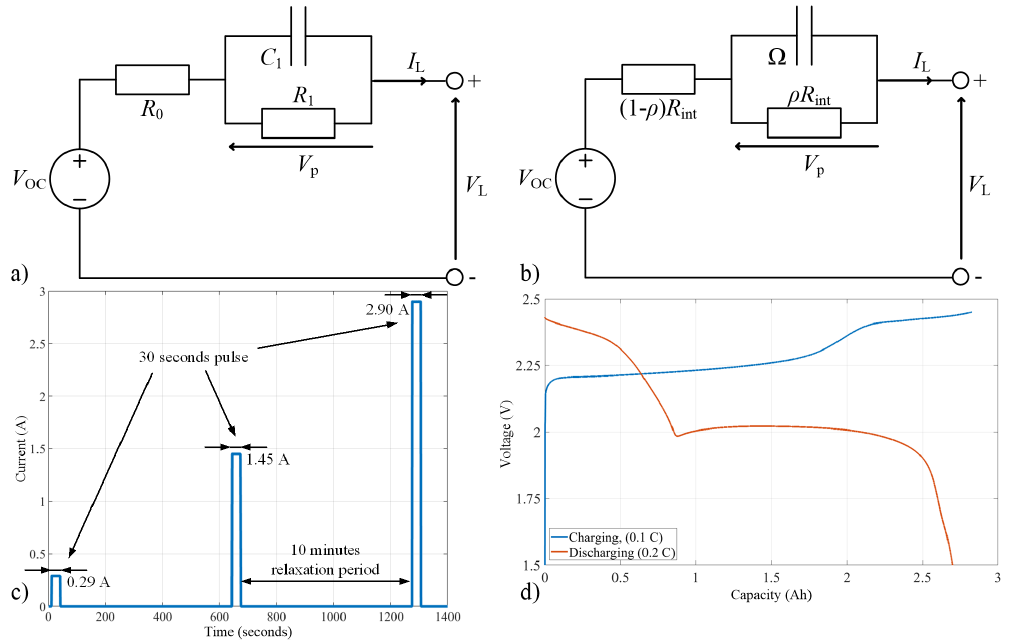
Figure 1. ( a ) Thevenin equivalent circuit model used for modelling the Li-S battery, ( b ) behavioural equivalent circuit model used for modelling the Li-S battery, ( c ) mixed pulse discharge test—the detail on three current pulses, ( d ) a typical continuous charging/discharging profile for a Li-S cell (measured at 25 ◦